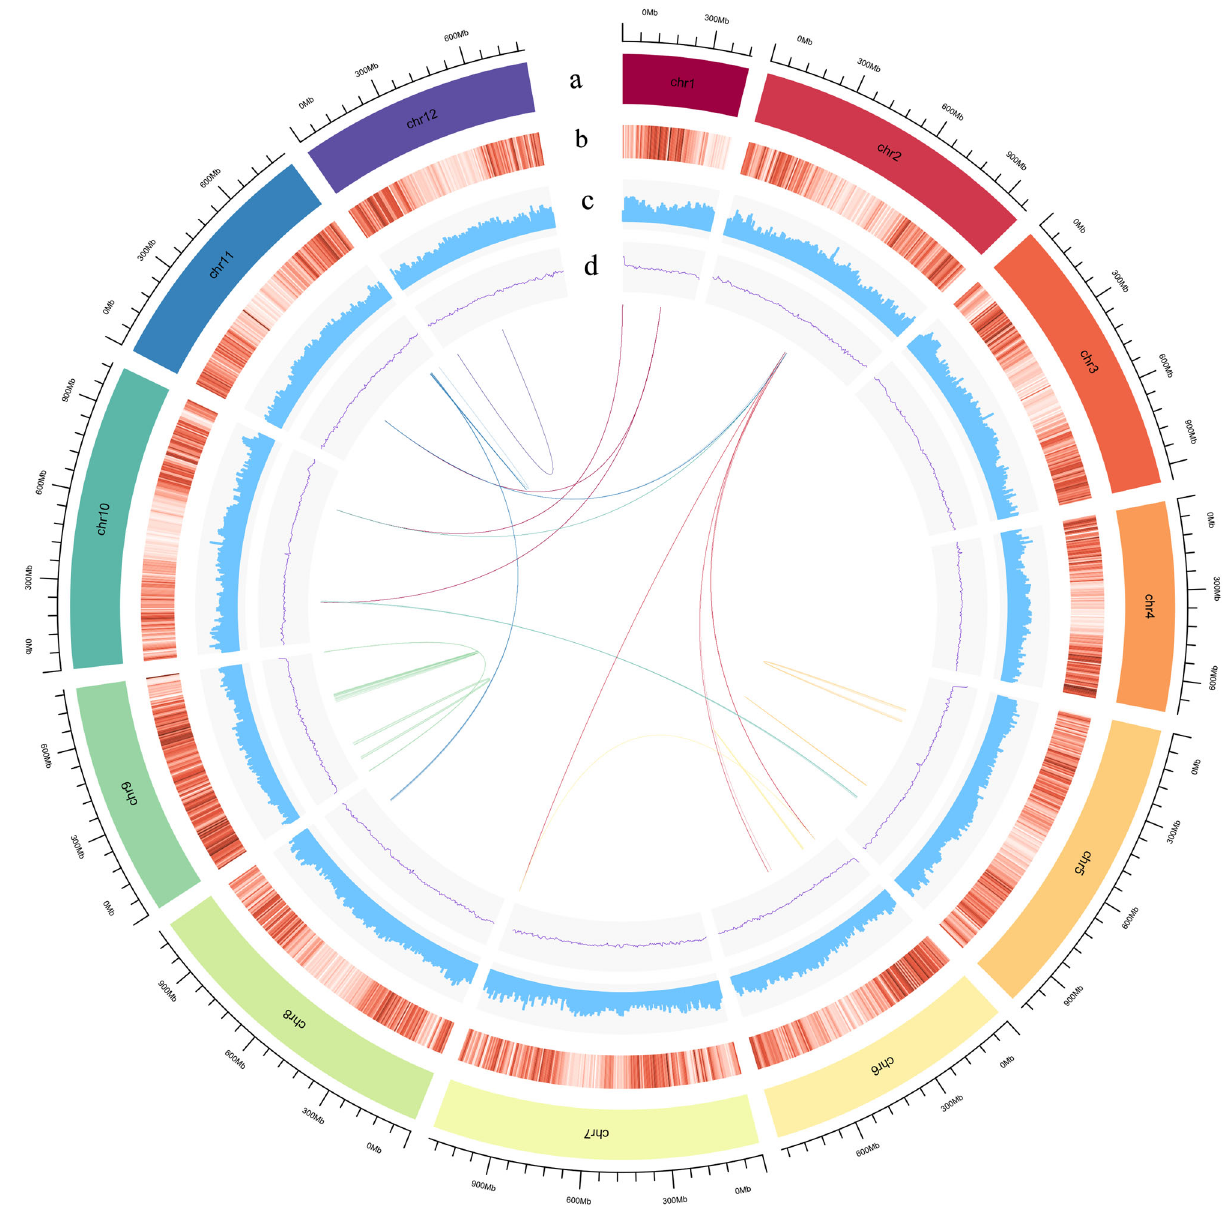
Fig. 1 Distribution of T. yunnanensis genomic features. a Circular representation of the 12 pseudochromosomes, b gene density (5 Mb window), c percentage of repeats (5 Mb window), d GC content (5 Mb window), and intragenomic syntenic regions denoted by a single line represent a genomic syntenic region covering at least fi ve